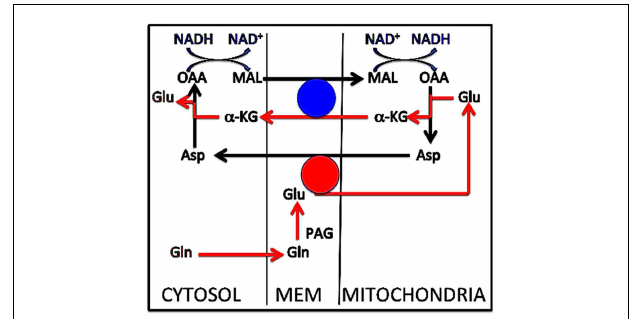
FIGURE 5 | Metabolic pathway for conversion of glutamine to glutamate in cultured cerebellar granule neurons . Glutamine enters the intermembranaceus space from the cytosol (red arrow at bottom of Figure). Here glutamate is formed by phosphate-activated glutaminase (PAG), but instead of returning to the cytosol, it enters the mitochondrial lumen and is transaminated to aspartate, coupled with transamination of oxaloacetate (OAA) to α -ketoglutarate ( α -KG). As in the malate–aspartate shuttle α -KG exits the mitochondrial membrane in exchange with incoming malate, and intramitochondrial malate is oxidized to oxaloacetate.The mitochondrially generated aspartate is the source of the cytosolic malate exchanging with α -KG after it has been transaminated to oxaloacetate and reduced to malate.Two transmitochondrial carriers are involved, (1) the glutamate/aspartate exchanger AGC1, shown by a red circle, which requires aralar [undisputed presence in neurons, except in the aralar − / − mice studied by Pardo et al. (2011), where glutamate synthesis may have been abrogated], and (2) the α -ketoglutarate/malate carrier (OGC), shown by a blue circle. As mentioned in the text this process is similar to that operating in the malate–aspartate shuttle, with the exception that glutamate in the latter originates in the cytosol, not in the mitochondrial intermembranaceus space.The interactions between oxaloacetate and malate must be coupled to conversion of NADH to NAD + in the cytosol and the reverse change in the mitochondria (top of Figure).This contributes to the quantitative correlation between glucose flux and glutamine/glutamate (GABA) cycle activity at different activity ranges. Modified from Palaiologos et al.